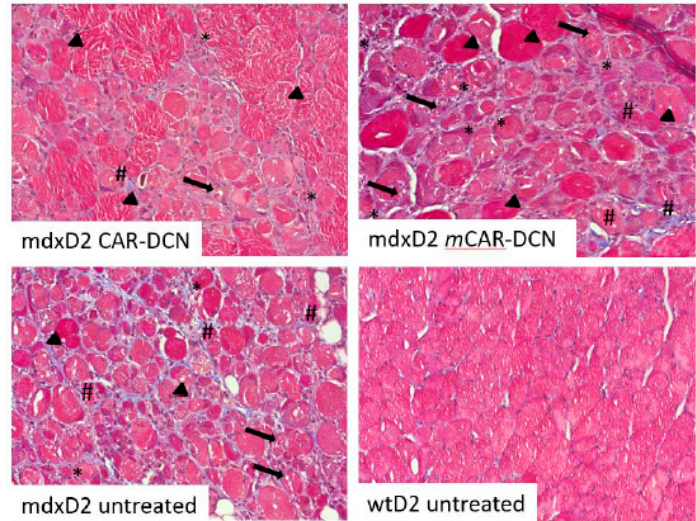
Figure 7. More robust regeneration after CAR-DCN treatment of mdxD2 mice. These representative Masson’s Trichrome pictures are from CAR-DCN, mCAR-DCN, or control three week treated mice. The vastus lateralis of the quadriceps was imaged at original magnification of 20×. Late stage regenerative fibers, identified by central nuclei and almost normal size (arrowheads); necrotic fibers are the cells with many gaps (arrows); immune infiltrate identified with closely packed nuclei (asterisks); and fibrotic areas identified by the blue staining (number sign) are indicated in the images. The mCAR-DCN treated muscle had more pathology as revealed by fewer normally sized muscles, more immune cells between muscle cells than in the CAR-DCN treated mice, and the distinctive presence of fibrotic areas. Original magnification 10×.